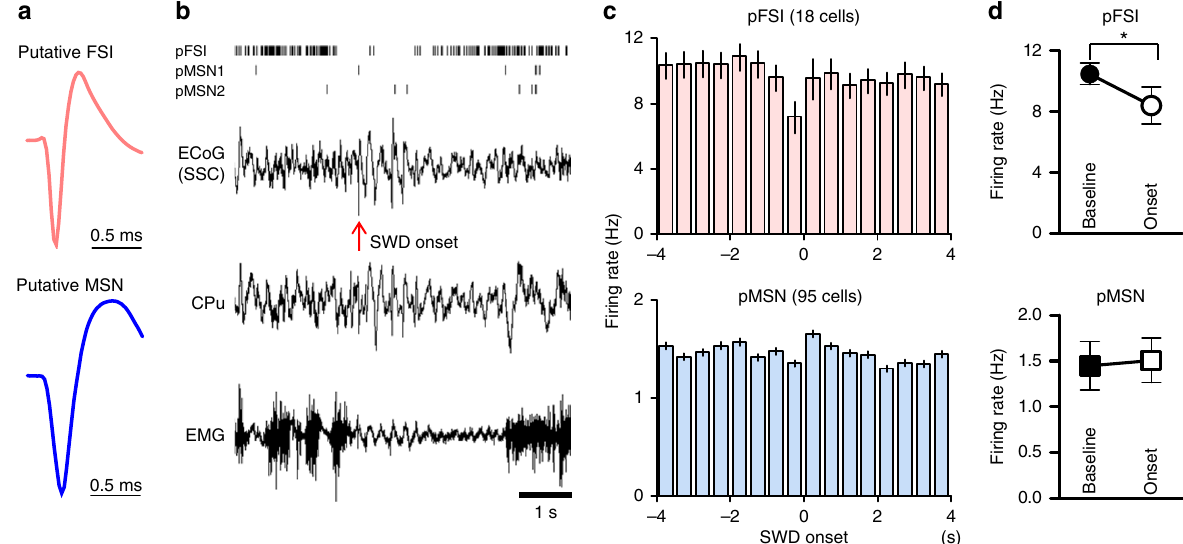
Fig. 7 Temporal down-regulation of striatal FSIs at SWD onset in Stxbp1 + / − mice. a Averaged spike waveforms of single units from a pFSI and a pMSN (FSI, 52,478 spikes; MSN 1,369 spikes). b Representative single unit activities of one pFSI and two pMSNs (raster plot, top), simultaneously recorded SSC-ECoG, EMG, and CPu LFP around the onset of cortical SWD (arrow). c Averaged peri-event time histograms (500 ms bins) of pFSI (18 cells) and pMSNs (95 cells) from 10 Stxbp1 + / − mice. The timings of the SWD onset were aligned at 0 s. d pFSIs activity at the onset of SWDs ( − 0.5 to + 0.5 s) signi fi cantly decreased compared to baseline ( − 5 to − 4 s), while pMSNs did not. pFSIs: baseline vs. onset, Mann – Whitney U test, * P = 0.0279, pMSNs: P = 0.5831. Mean± SEM. * P <